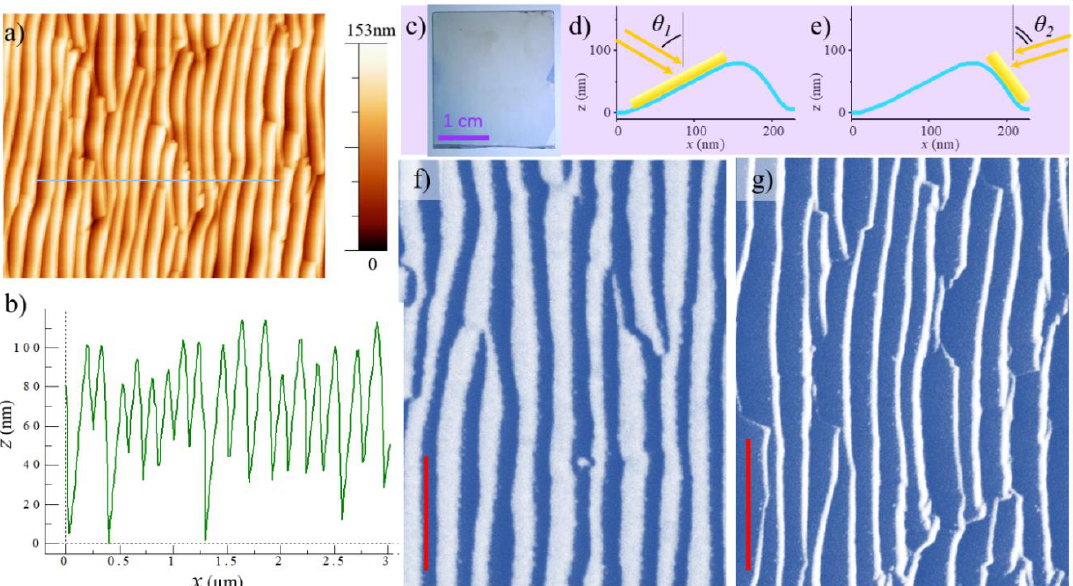
Figure 1. , ( a , b ) AFM topography and cross-section line profile of the nanopatterned glass template; ( c ) Picture of the sample: the plasmonic nanostructures homogeneously extend over large area (cm 2 ); ( d , e ) sketch of the glancing angle Au evaporation growth on the wide and on the narrow facets, respectively; and ( f , g ) SEM images of the tilted Au nanostripe arrays grown under condition of panel (d,e), respectively. The red scale bars in panel ( f , g ) correspond to 500 nm and 1 µm, respectively.